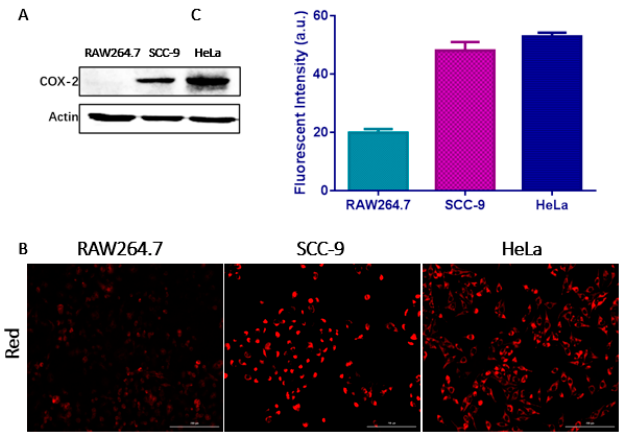
Figure 5. ( A ) Western blot showing COX-2 expression level in RAW 264.7, SCC-9 and HeLa cells. ( B ) Fluorescence images of RAW 264.7, SCC-9 and HeLa cell lines with fluorescent microscopy. All cells were treated with CCY-5 (1 µ M) for 30 min ( λ ex: 628 nm; Red, λ em: 685 nm; All the images share the same scale bar: 200 µ m). ( C ) Quantitative image analysis of the average total fluorescence intensity of HeLa, SCC-9 and RAW 264.7 cells (n = 3). * p < 0.05.